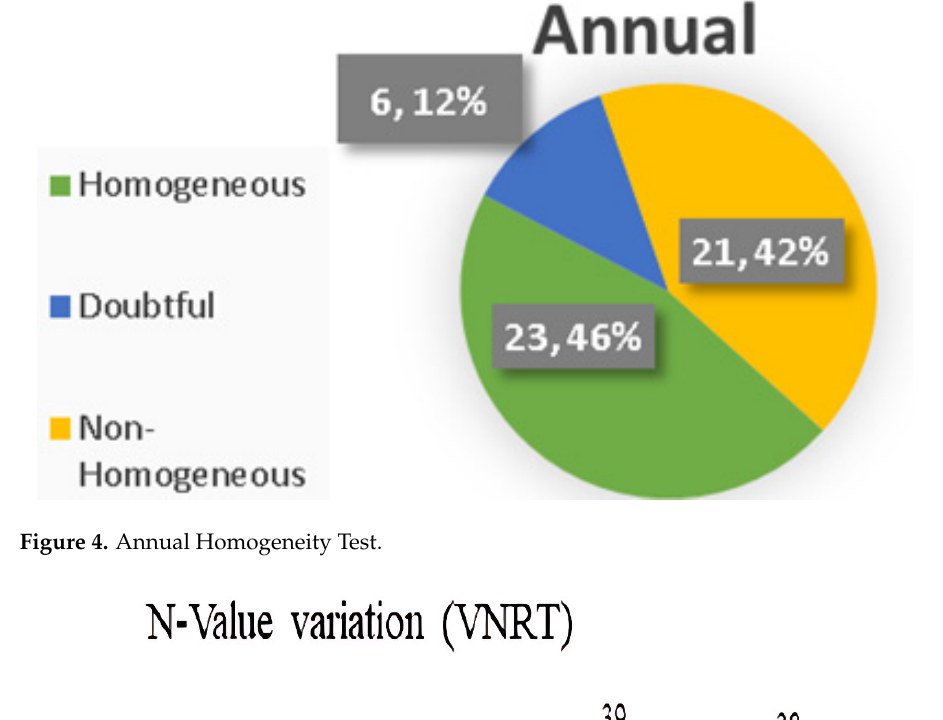
Figure 3. Monthly Homogeneity Test.